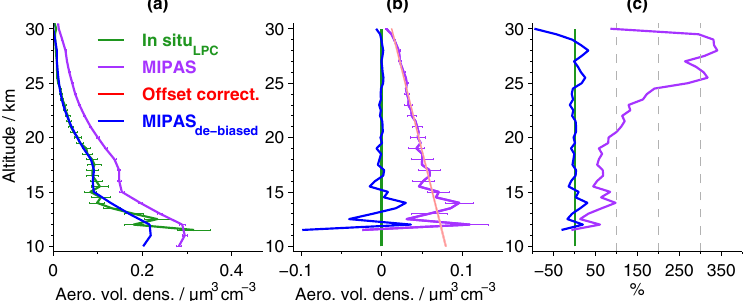
Figure 4. Aerosol volume densities by MIPAS and in situ data from Laramie, Wyoming. (a) Mean profiles for data in Fig. 3 (excluding the 28 July 2011), and their 1 σ errors, based on the estimated measurement uncertainties. De-biased MIPAS values are shown in blue; the original data are shown in purple. (b) Absolute and (c) relative differences of MIPAS to LPC in situ data. Differences are calculated for the mean profiles shown in (a) . In (b) the uncertainties of the absolute differences between in situ and MIPAS data are shown (horizontal purple lines; error propagation based on MIPAS and in situ errors presented in a ). Red line: linear fit to the profile of absolute differences (purple line) between 18 and 30km, used to reduce the bias to the LPC in situ measurements (light red area: 1 σ uncertainty in the linear fit).